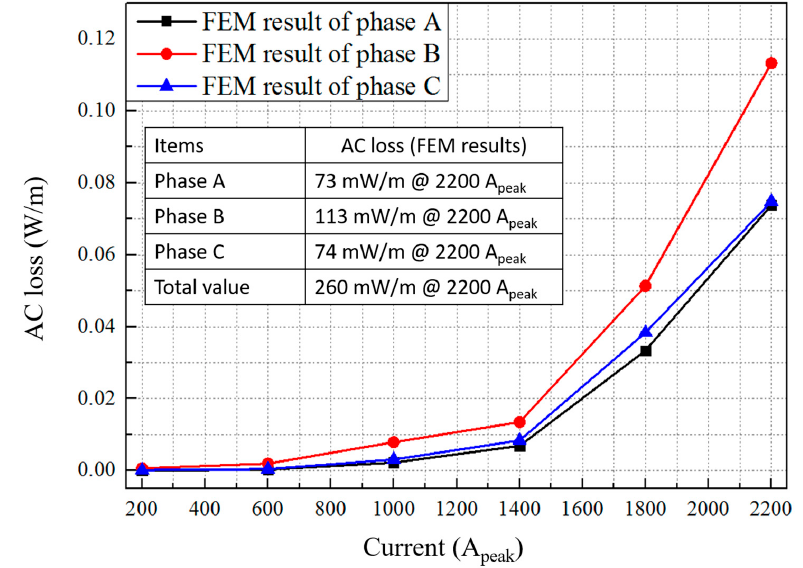
Figure 6. AC loss analysis results for single-phase currents of the tri-axial HTS power cable.